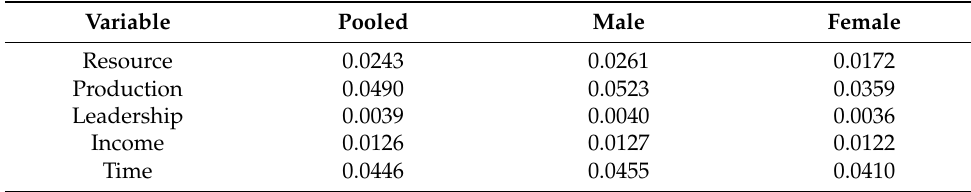
Table 4. The mean empowerment domains across gender.